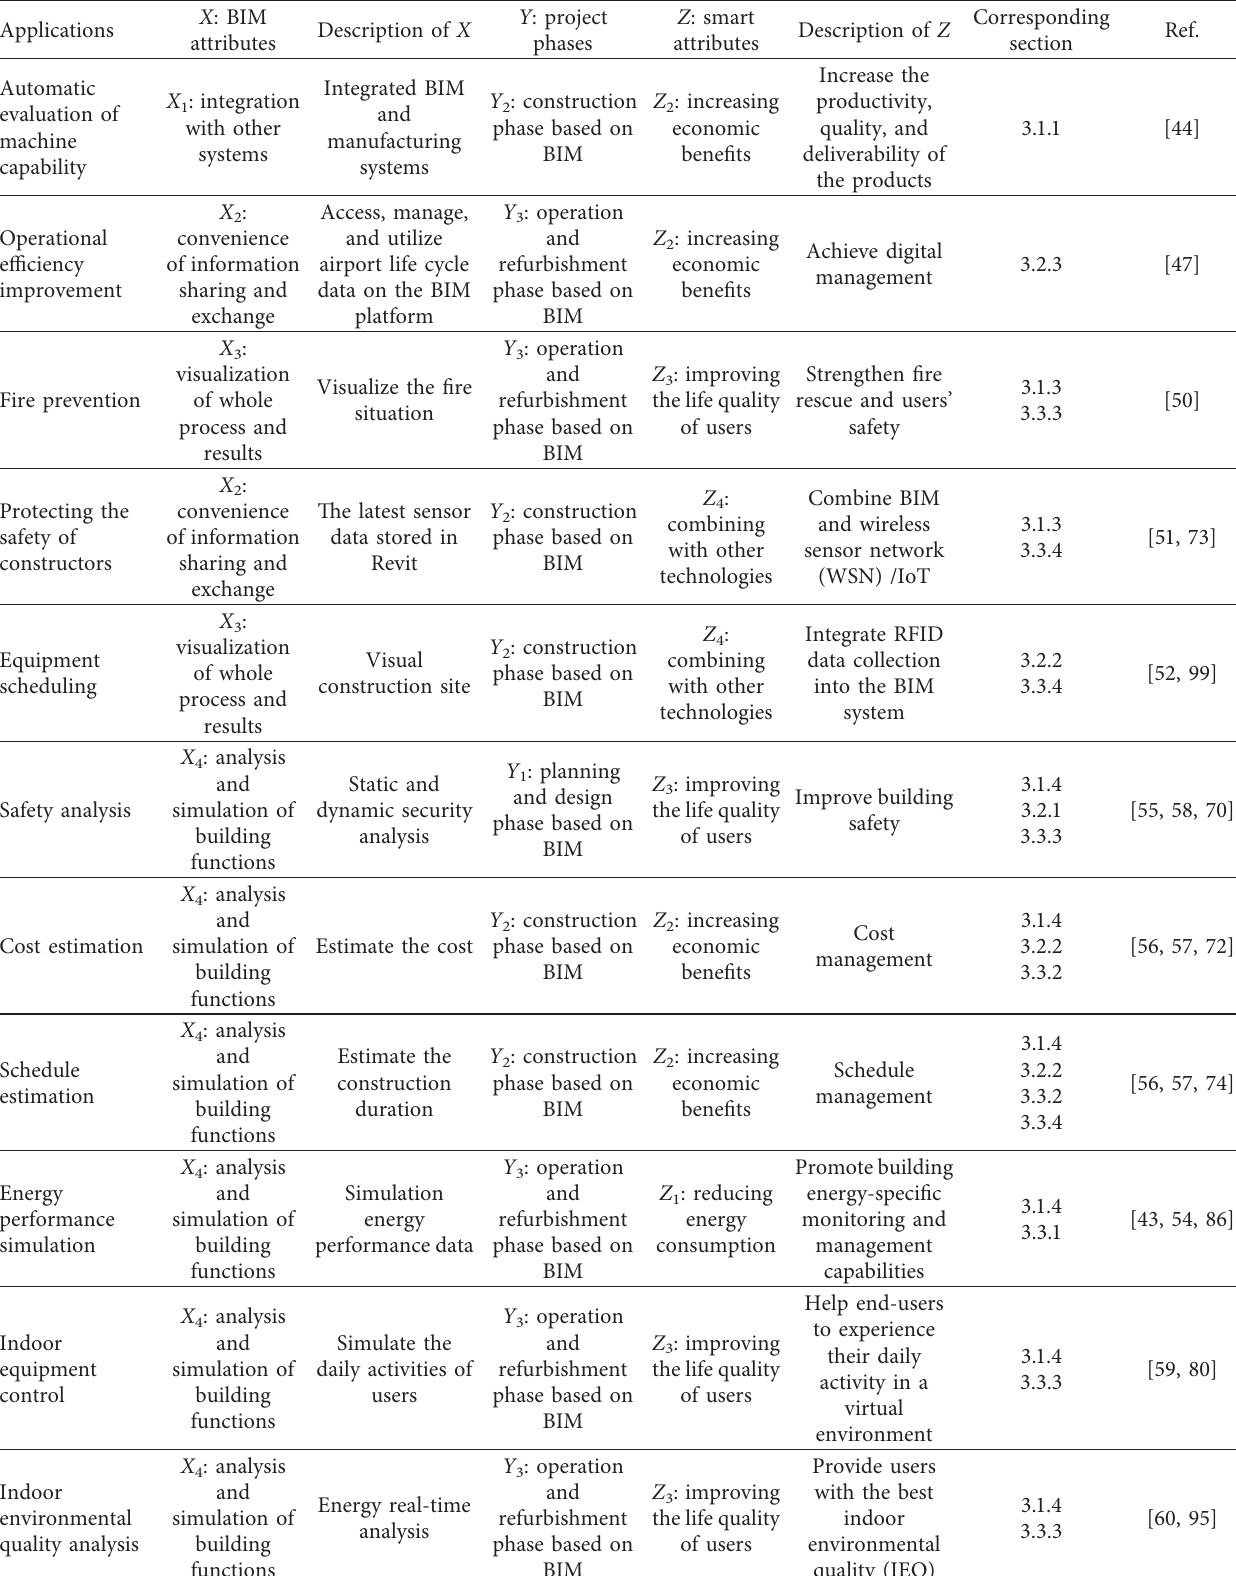
Table 5: Interaction of BIM attributes ( X ), project phases ( Y ), and smart attributes ( Z ).